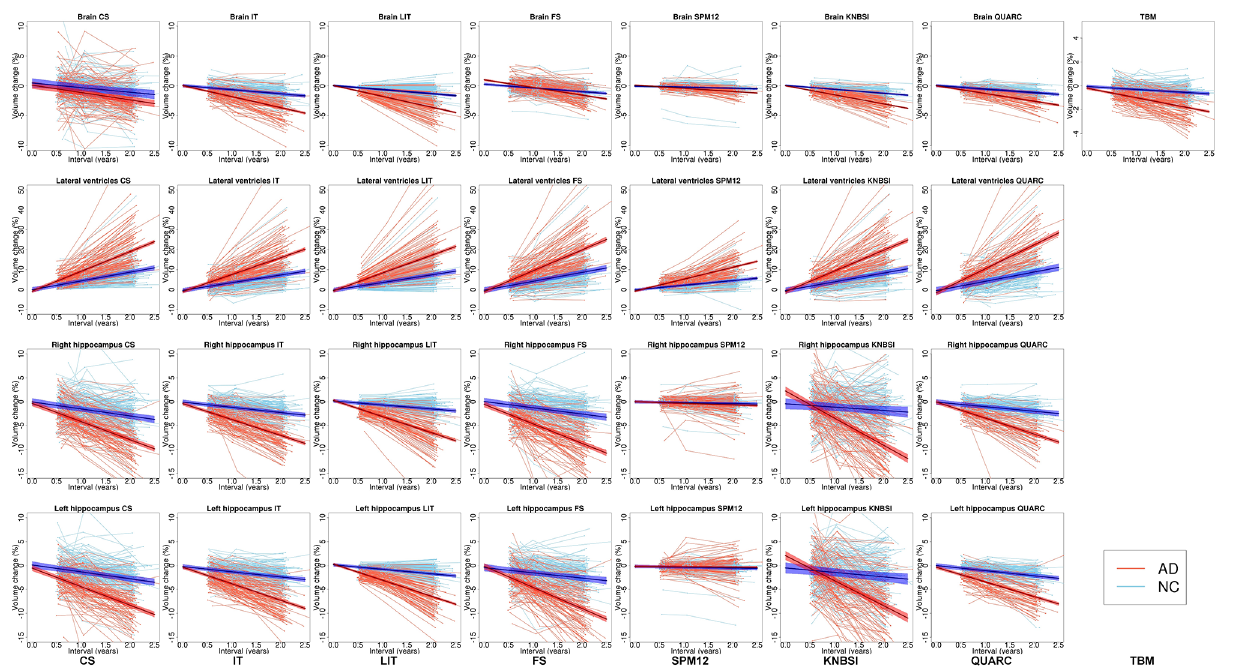
Fig 6. Longitudinal individual and linear mixed model with confidence intervals for the NC (blue) and AD (red) groups. Brain, ventricular and left/right hippocampi volume changes for CS, IT, LIT,FS, SPM12, KNBSI and TBM. Each thin full line represents an individual subject volume. Thicker lines represent the LME model for the respective groups while the shaded bands represent the 95% confidence interval on the mean